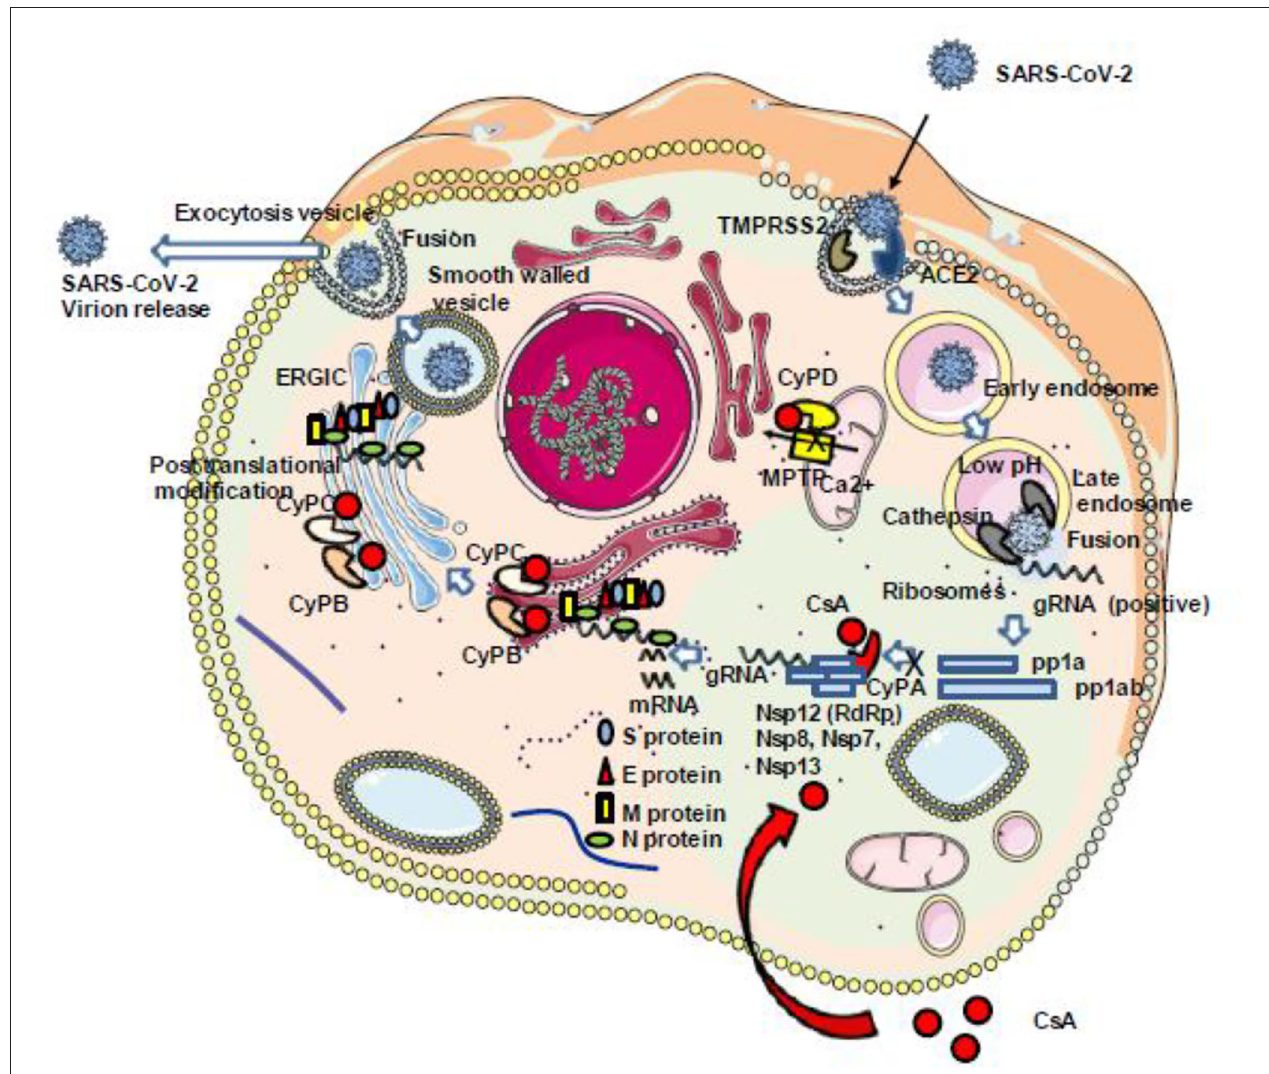
FIGURE 6 | Schematic representation of the antiviral properties of CsA. Once the SARS-CoV-2 genome starts to be transcribed into pp1a and pp1ab, the RNA-dependent RNA polymerase (Nsp12) should interact with several other viral (Nsp8, Nsp7, Nsp13) and cellular (CypA) proteins to construct a replication complex. This complex is required for the viral replication cycle to be completed with the synthesis of the structural proteins S, E, M, and N. This step can be inhibited through the interaction between CsA and CypA (see text for details regarding the different steps of the SARS-CoV-2 cycle which can be inhibited by CsA). ACE2, angiotensin-converting enzyme 2; CsA, cyclosporin A; CyPA, CyPB, CyPC, and CyP, cyclophilins A, B, C, and D; gRNA, genomic RNA; Nsps, non-structural proteins; ERGIC, endoplasmic reticulum–Golgi intermediate